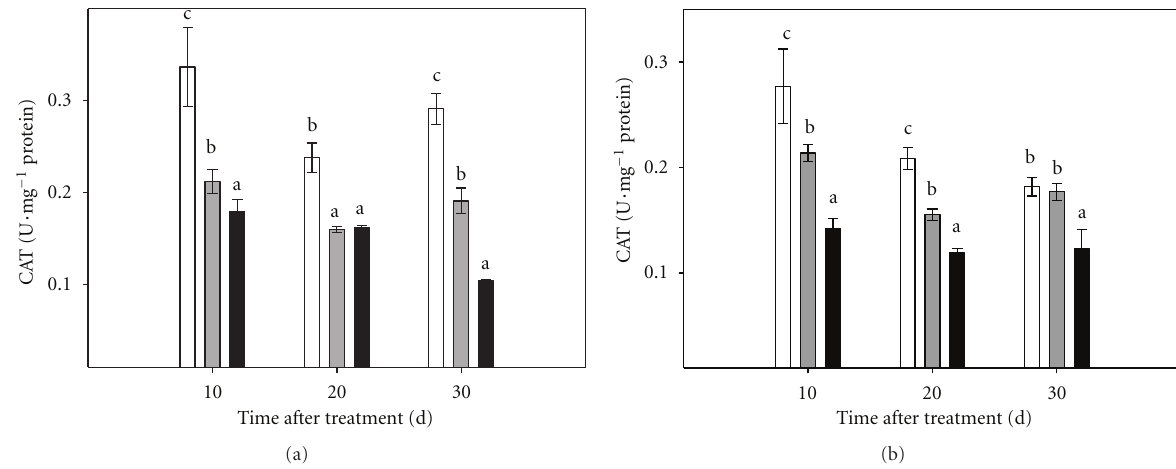
Figure 5: E ff ect of osmotic stress on CAT activity in Carrizo citrange plants cultured in vitro . (a): aerial part of intact plants; (b): root tissue of intact plants. Control plants (white bar), plants cultured under moderate (grey bar) or severe (black bar) osmotic stress conditions. Each point corresponds to the average ± standard error of six independent determinations. Di ff erent letters denote statistical significance at P < 0.05.